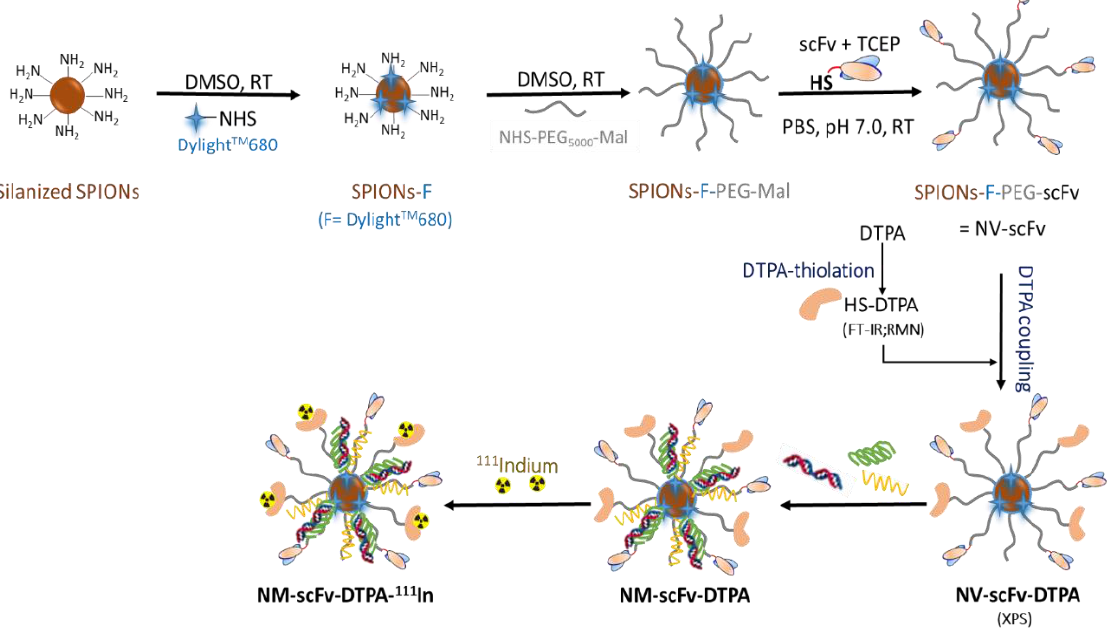
Figure 2. Schematic representation of NM-scFv-DTPA- 111 In synthesis.